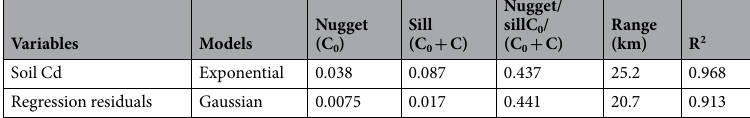
Table 4. Semivariogram parameters of soil Cd and the regression